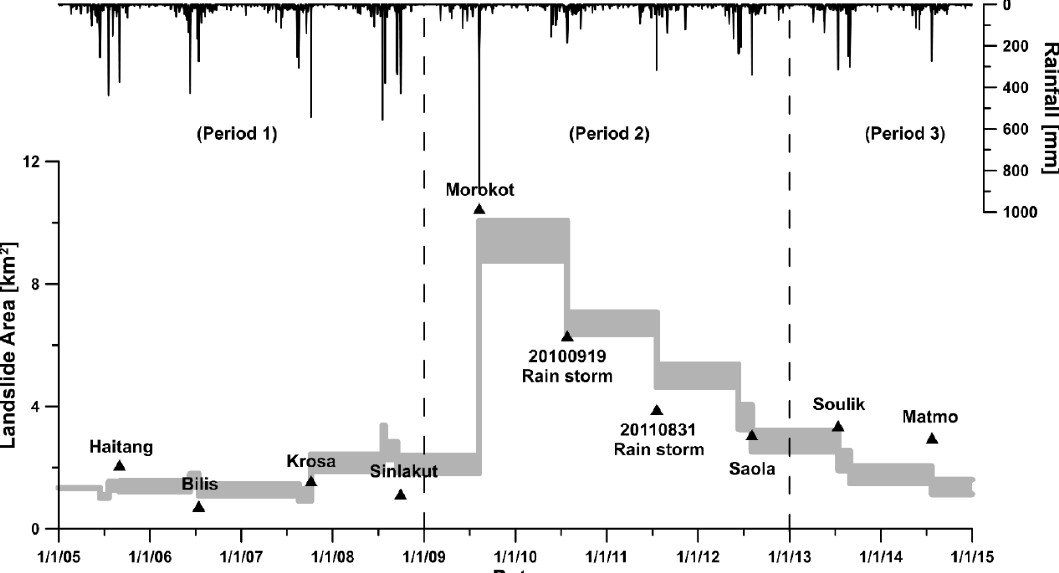
Figure 5. Simulated time-series total landslide area (km 2 ) by the landslide model. Black triangles represent observed total landslide area, and the gray zone is the envelope derived from the 23 non-inferior parameter sets. Observed daily rainfall is also illustrated as a reference. The study period was divided into three periods for the sake of detailed discussion (Please refer to Section 3.3).